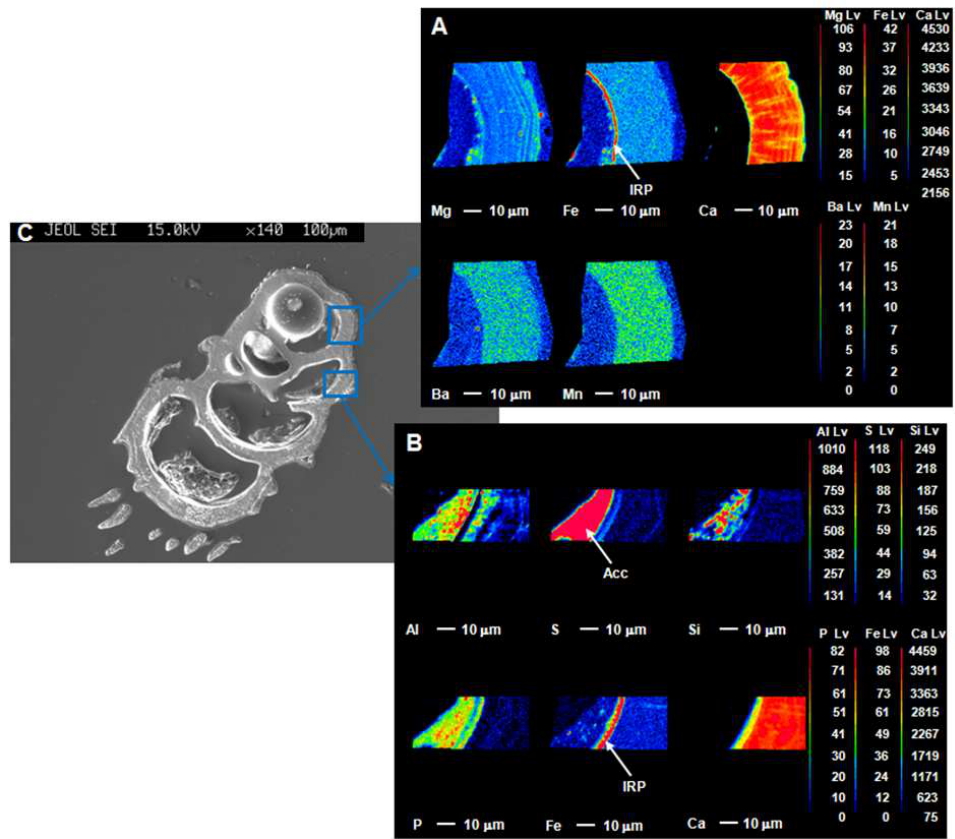
Fig. 2. EMP elemental mappings (A, B) and secondary electron image (C) for an Uvigerina peregrina specimen from 579 m water depth (M77-1-487/MUC-39) on an exposed section of the foraminiferal test. Distribution of Ca, Mg, Fe, Ba, Mn, Al, S, Si and P in the foraminiferal test. All intensity values are expressed in counts per second (cps) as shown in the color bars. IRP: Fe rich phase at inner test surface, Acc: accumulations inside the test